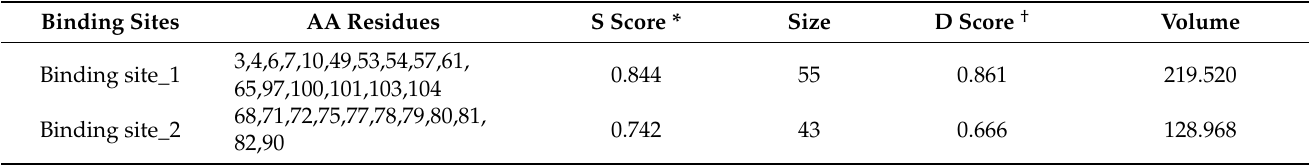
Table 3. SiteMap properties of MDR Ab-EP.